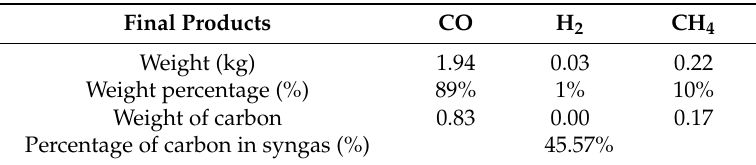
Table 2. Overall carbon content of syngas upon